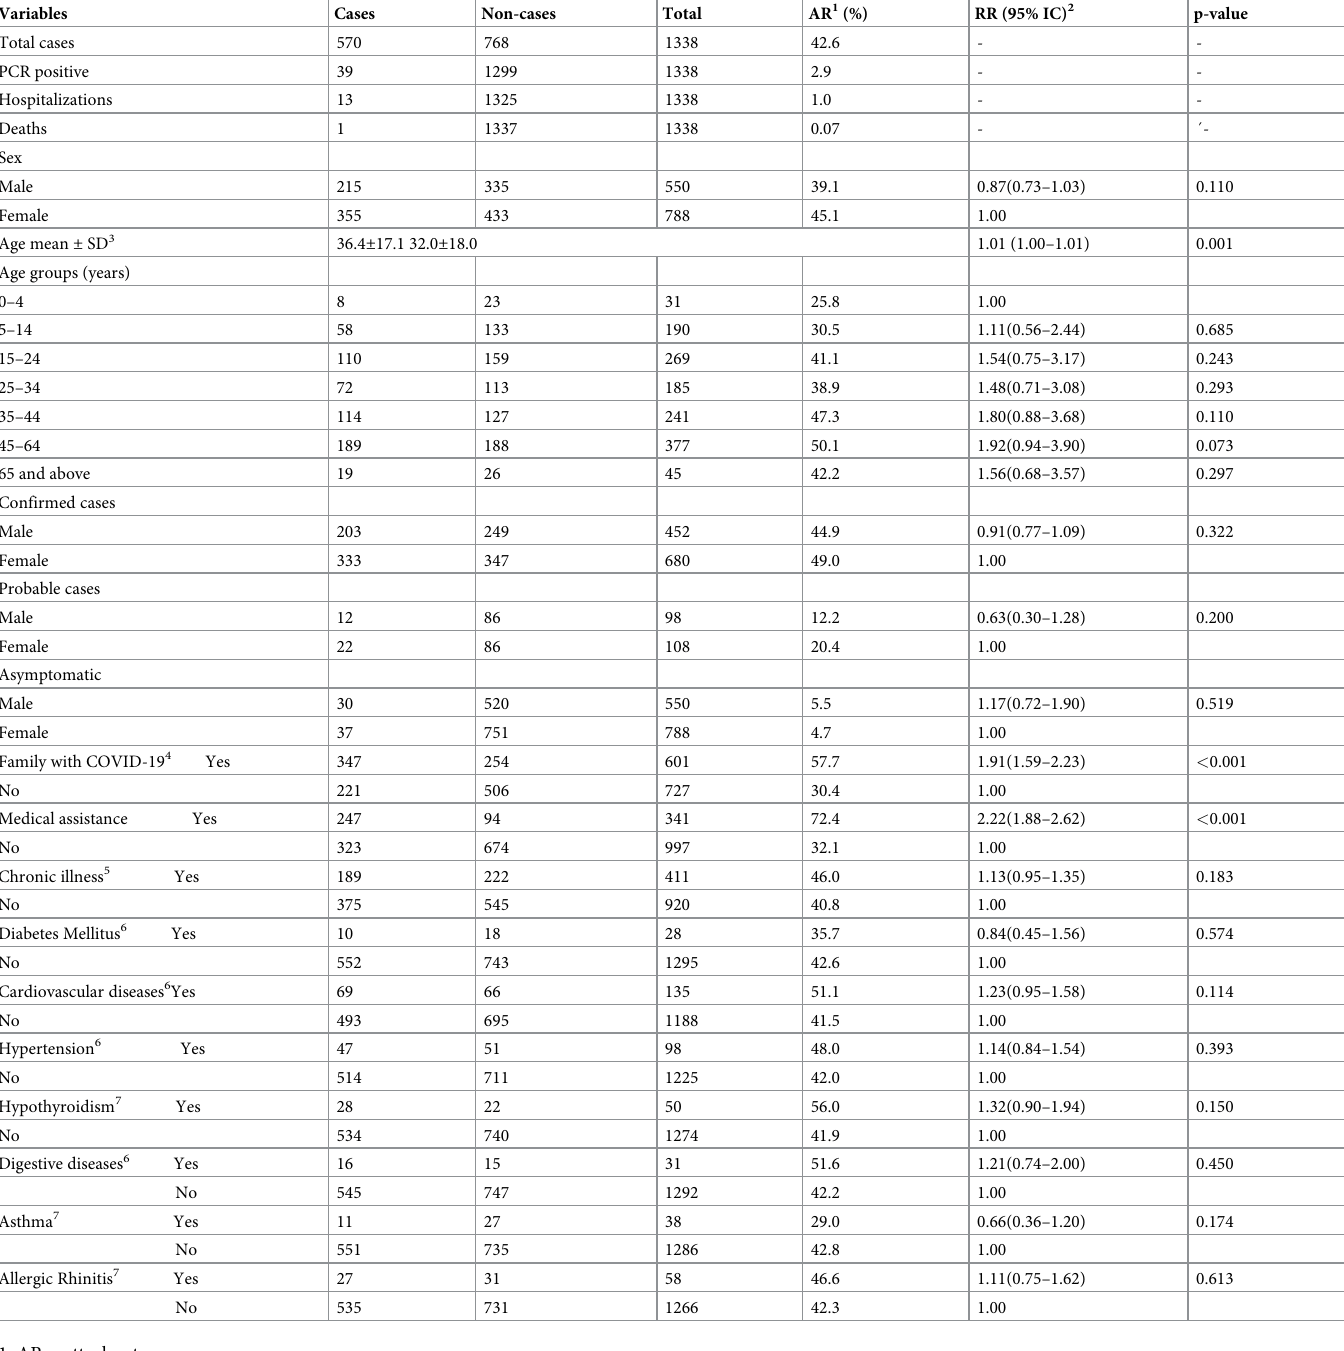
Table 3. Characteristics of patients of COVID-19. From January 1 to June 31, 2020, Borriana.